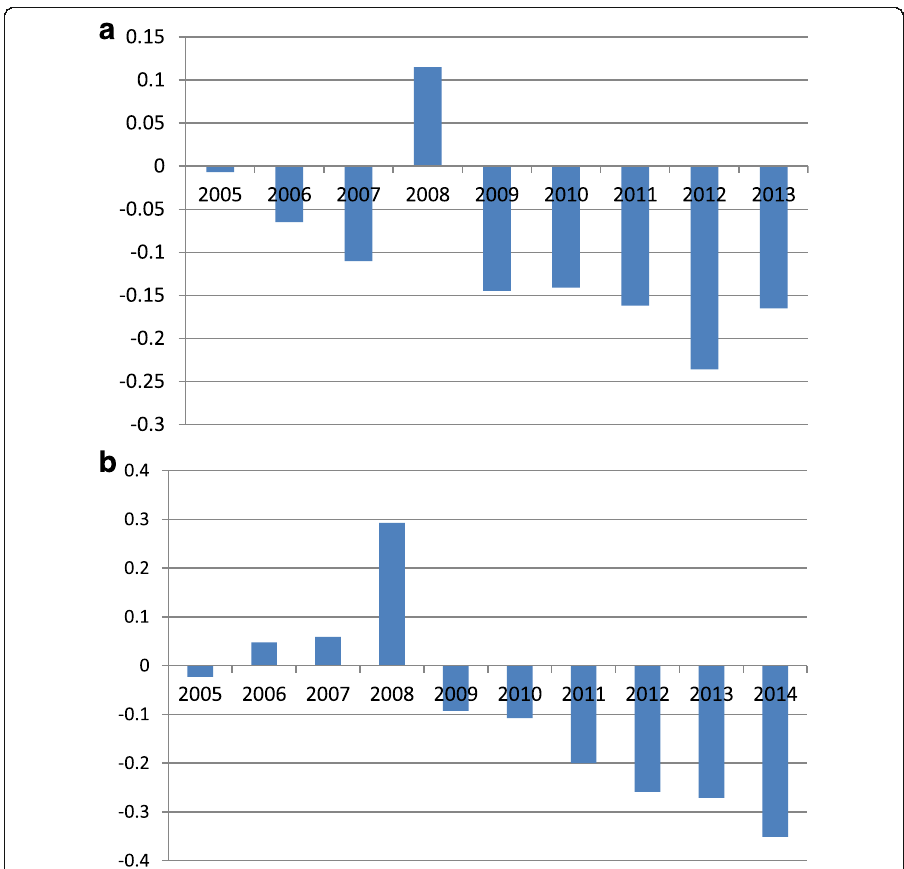
Fig. 8 Phillips curve in Italy: coefficients of year dummies interacted with province-level unemployment rates. Effect on wages calculated after removing composition effects and turnover. a Firms. b Workers. INPS data: sample of firms and workers. Robust standard errors indicate that the coefficients are negative and significantly different from zero after 2009 (at standard significance